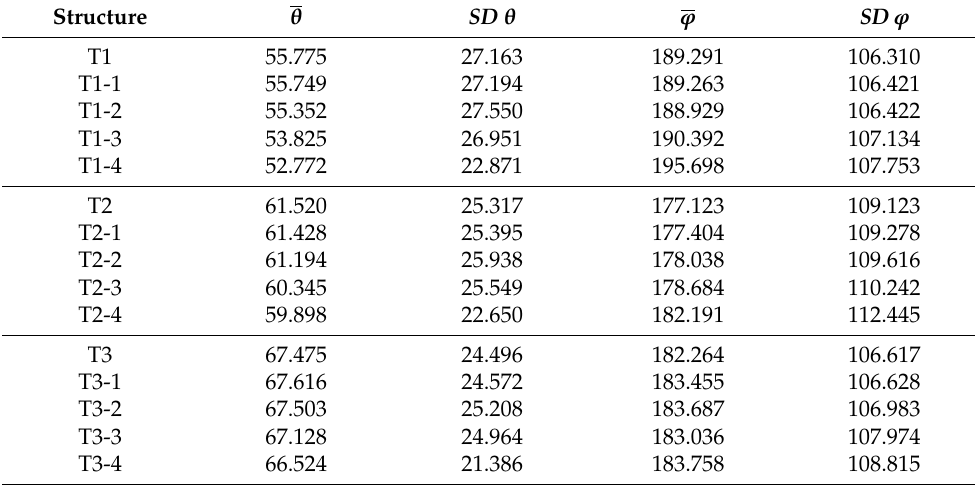
Table 3. Average and standard deviation for leaf zenith and azimuth angles for the structures of all stages.